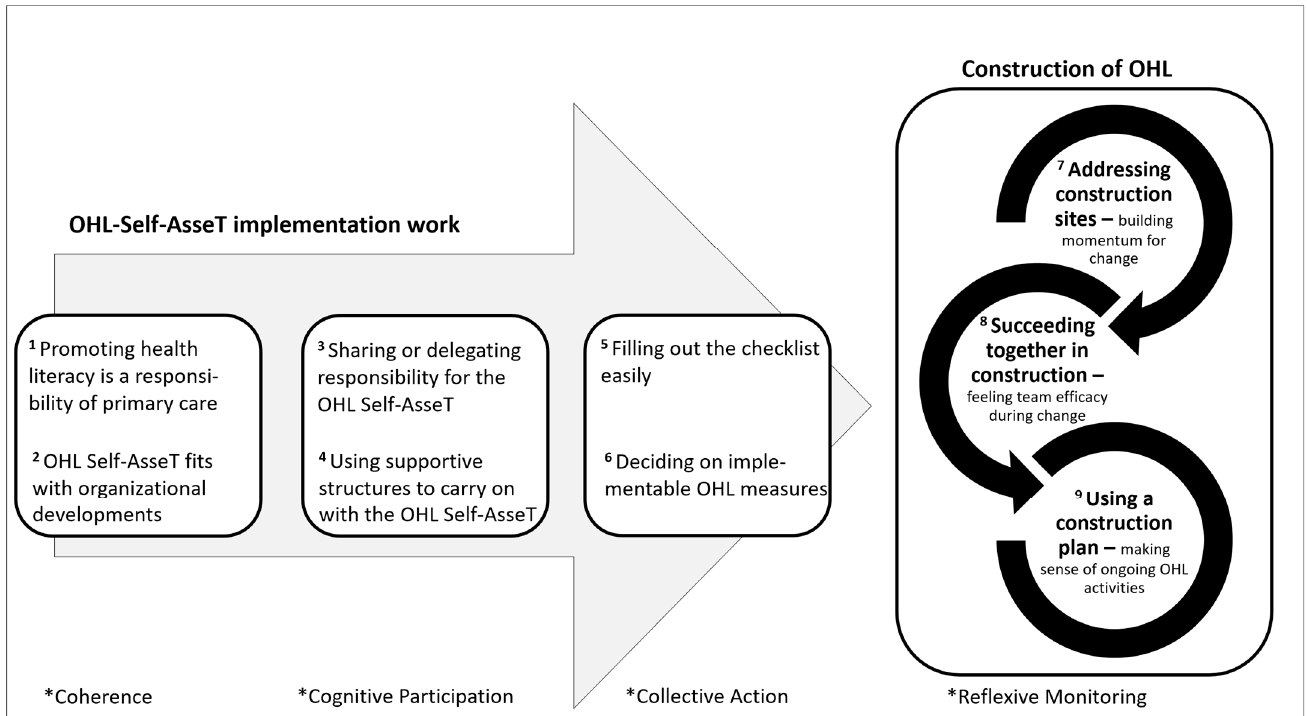
Figure 2. Thematic map: OHL Self-AsseT implementation work leading to construction of OHL in primary care settings.